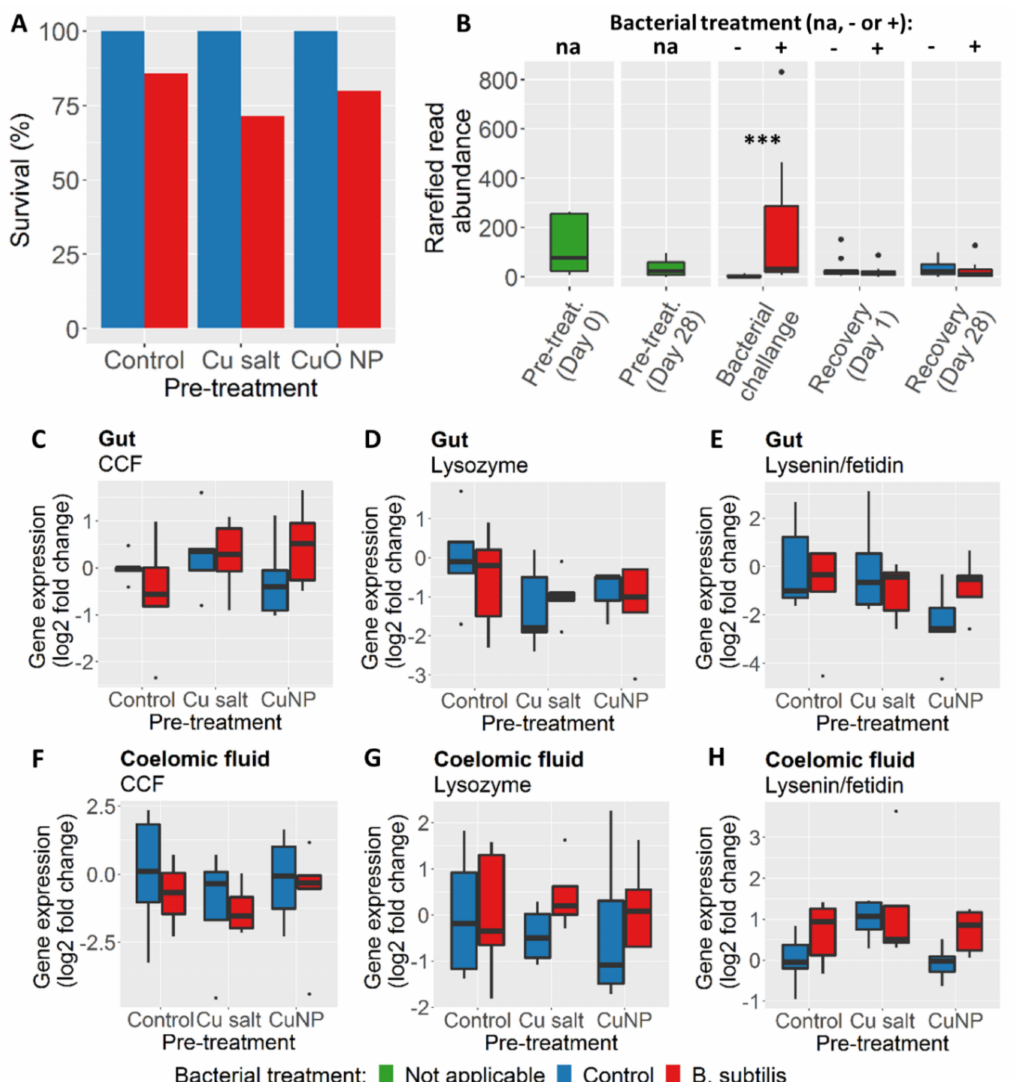
Figure 5. ( A ) Survival at day four of the bacterial challenge. ( B ) Boxplots of rarefied read abundance of Bacillus persamplepoint. Annotationattopofthegraphindicatesbacterialtreatment: na(notapplicable), − (PBS control), and + ( B. subtilis treatment). Triple asterisks indicate statistical significance between bacterial challenge control and bacterial challenge treatment with p < 0.001. Relative high abundance of Bacillus at ‘pre-treatment day 0’ is driven by the two samples in that sample group (Figure S2). Boxplots of fold change in gene expression of earthworm immune responses in ( C – E ) gut tissue and ( F – H ) coelomic fluid at ‘bacterial challenge day 2’. All gene expression values are log2 fold change values derived through 2 − ∆∆ Ct method. Expression values represent fold changes of treatments compared to control animals (control pre-treatment + control bacterial challenge) and are normalized to the expression of the housekeeping gene EF1 α . There were no significant di ff erences in gene expression between groups for all tested genes ( α = 0.05). Di ff erent colours in all panels indicate di ff erent bacterial challenge treatments. CCF, coelomic cytolytic